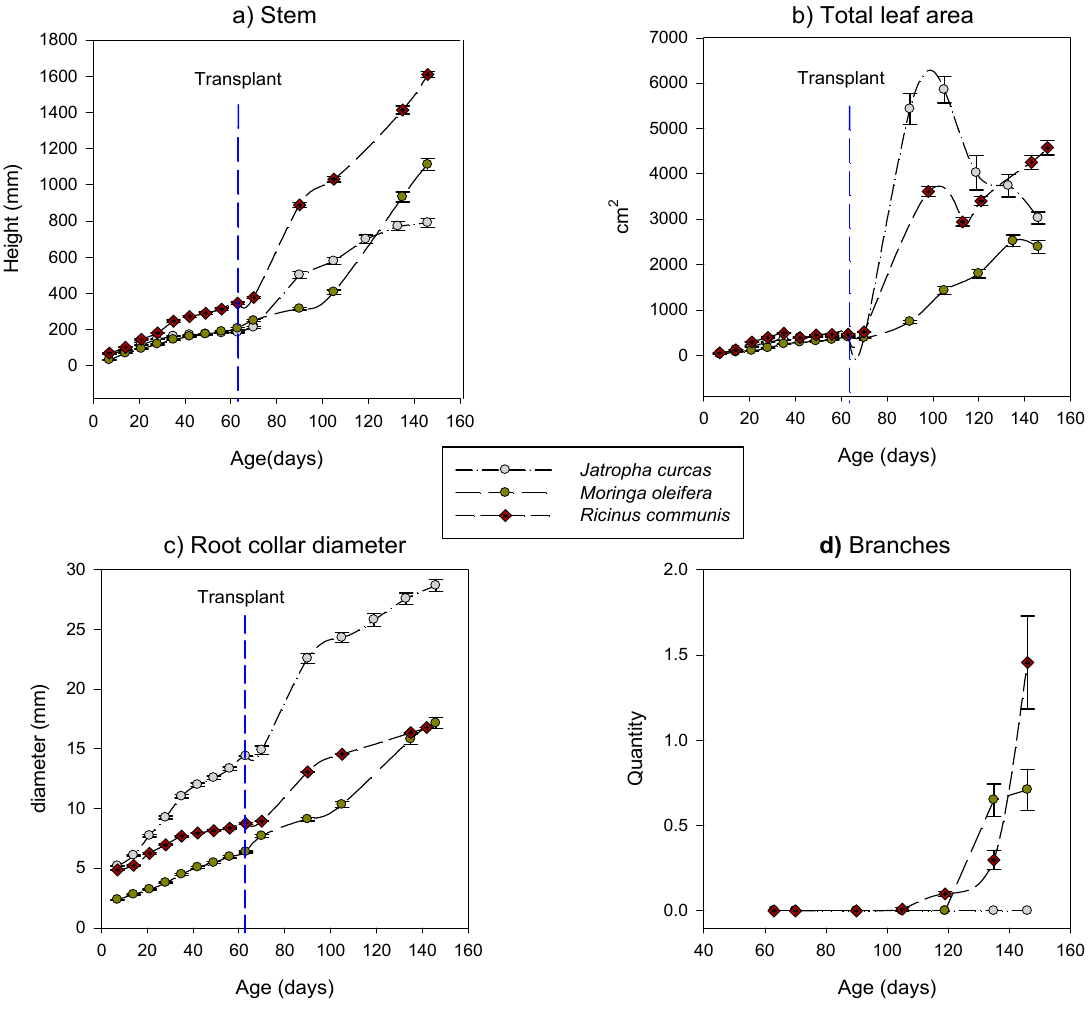
Figure 2. Average growth curves of Jatropha curcas , Moringa oleifera , and Ricinus communis seedlings. ( a ) Stem height; ( b ) the total leaf area represents the area of the youngest mature leaf by the number of leaves; ( c ) diameter at the base of the stem; and ( d ) branch production. None of the species registered branches before transplant; thus, the dashed vertical line representing the day of transplant was not drawn for this variable at (d. Error bars represent the standard error of the mean.